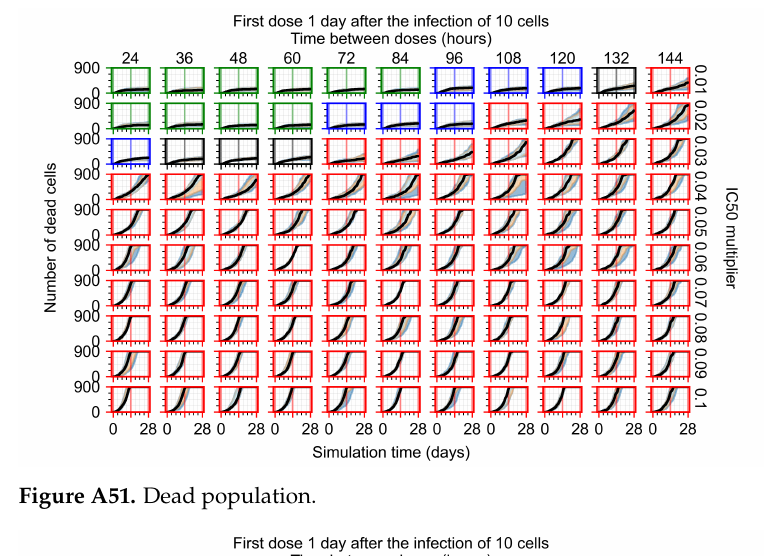
Figure A50. Infected (secreting extracellular virus).